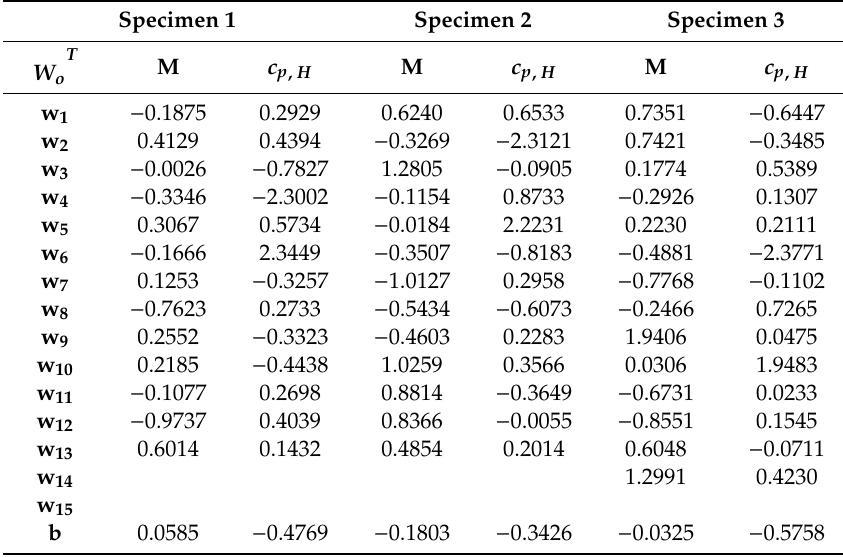
Table A5. Output synaptic weights of La-Fe-Co-Si ANNs.